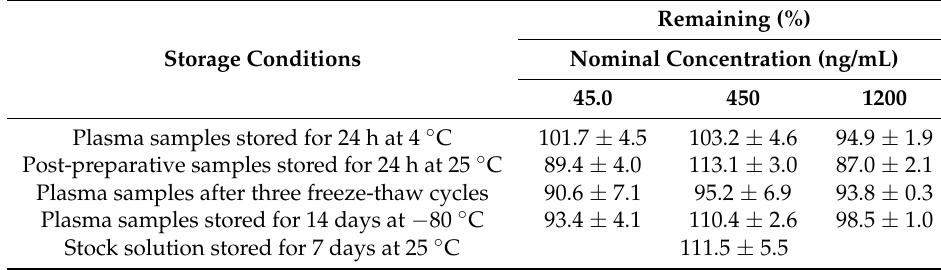
Table 2. Stability Profiles of Tangeretin a .